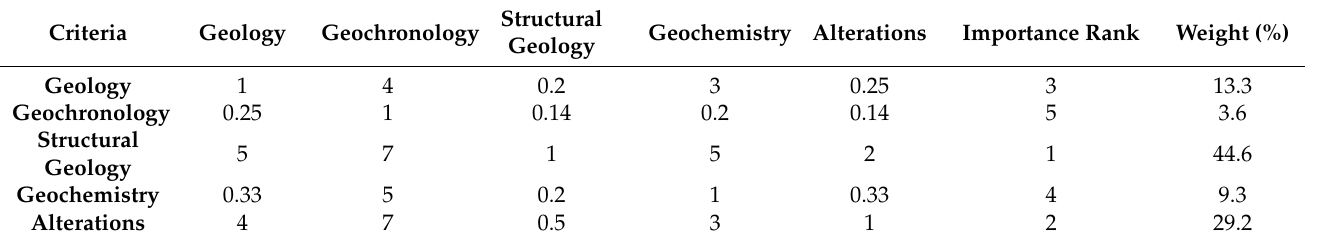
Table 8. Paired comparison matrix and calculated weights for each of the main criteria by AHP method.